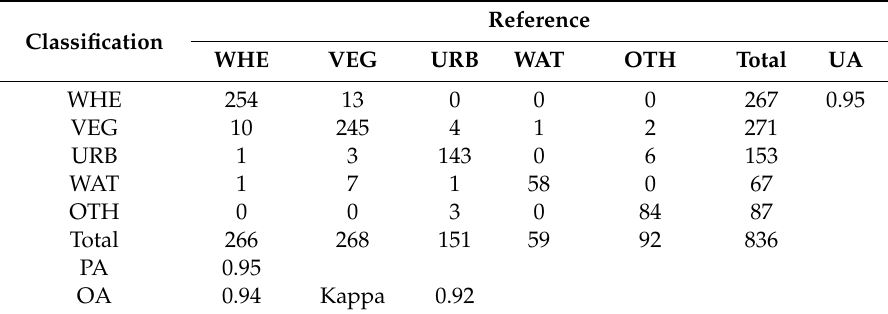
Table 3. The error matrix of SVM. WHE = Wheat, VEG = Vegetation, URB = Urban, WAT = Water,